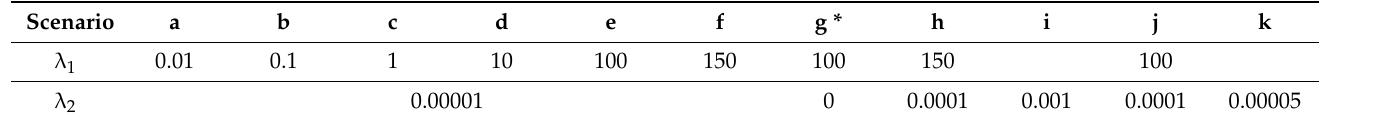
Table 2. Tuning-parameter scenarios.